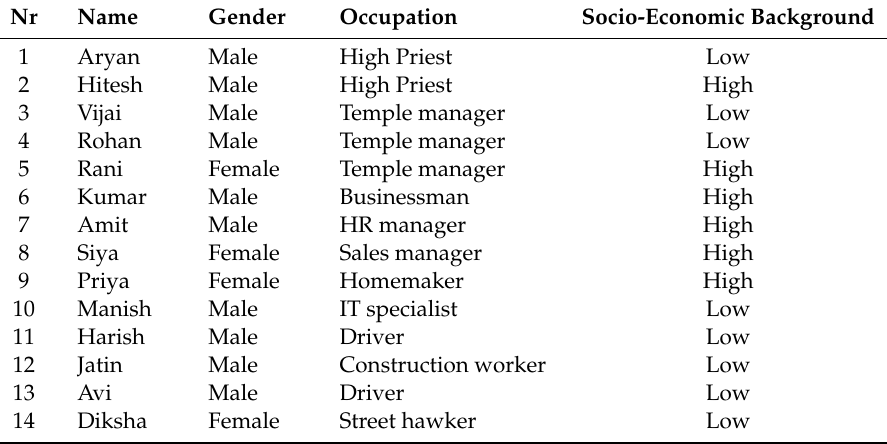
Table 1. Research participants (note: pseudonym names are